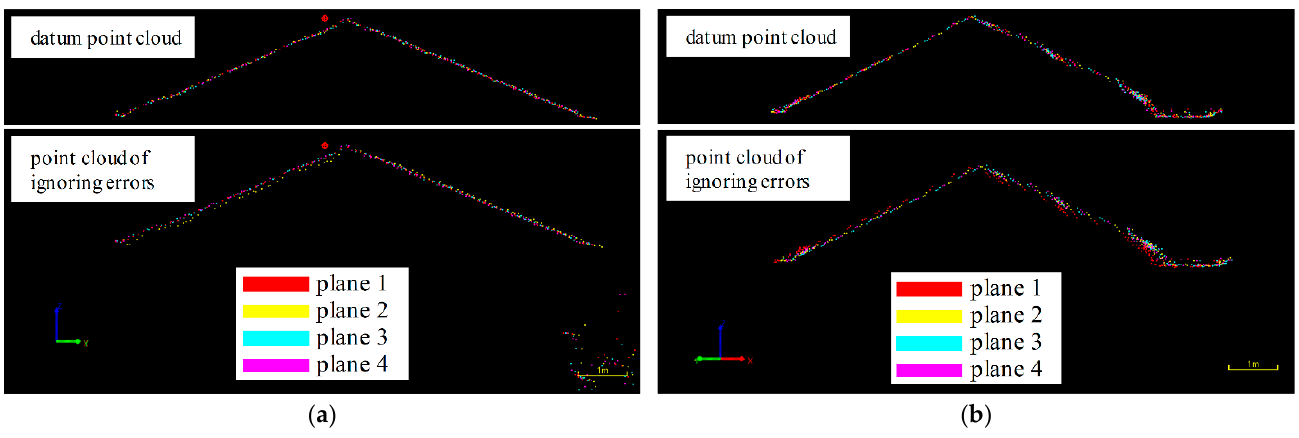
Figure 23. Vertical section of point cloud in opposing flight strips (flight 2 and flight 3) with installation angle compensation.